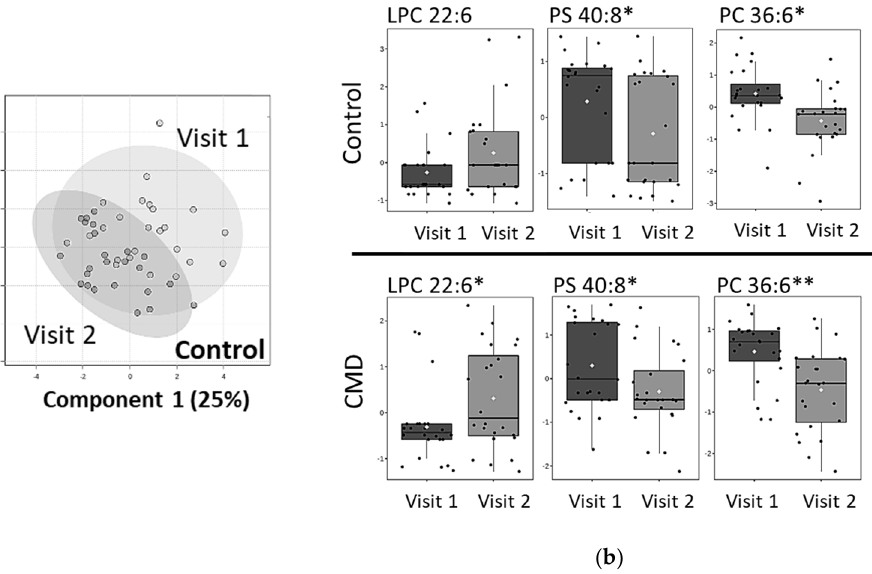
Figure 10. Longitudinal analysis of lipidome ( a ) Principal Component Analysis (PCA) of CMD and Control groups at Visit 1 and Visit 2. ( b ) Whisker plots of statistically significant lipids in control and CMD groups. In control group, 40:8 PS and 36:6 PC have p values of 0.04 and 0.002, respectively. LPC 22:6 is not statistically significant ( p value 0.07). In CMD group, 40:8 PS ( p value 0.04), 36:6 PC ( p value 0.001), and 22:6 LPC ( p value 0.03). Asterisks indicate statistical significance with * p value < 0.05 and ** p value < 0.001